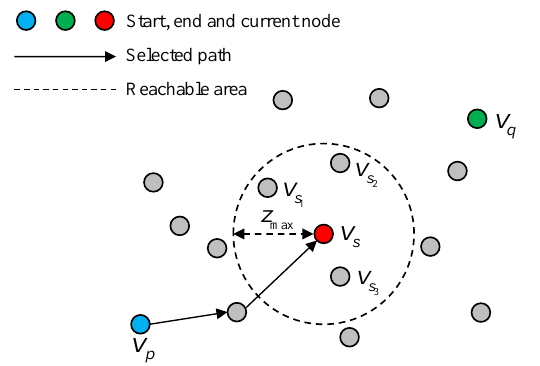
Figure 3. Improved A* strategy schematic